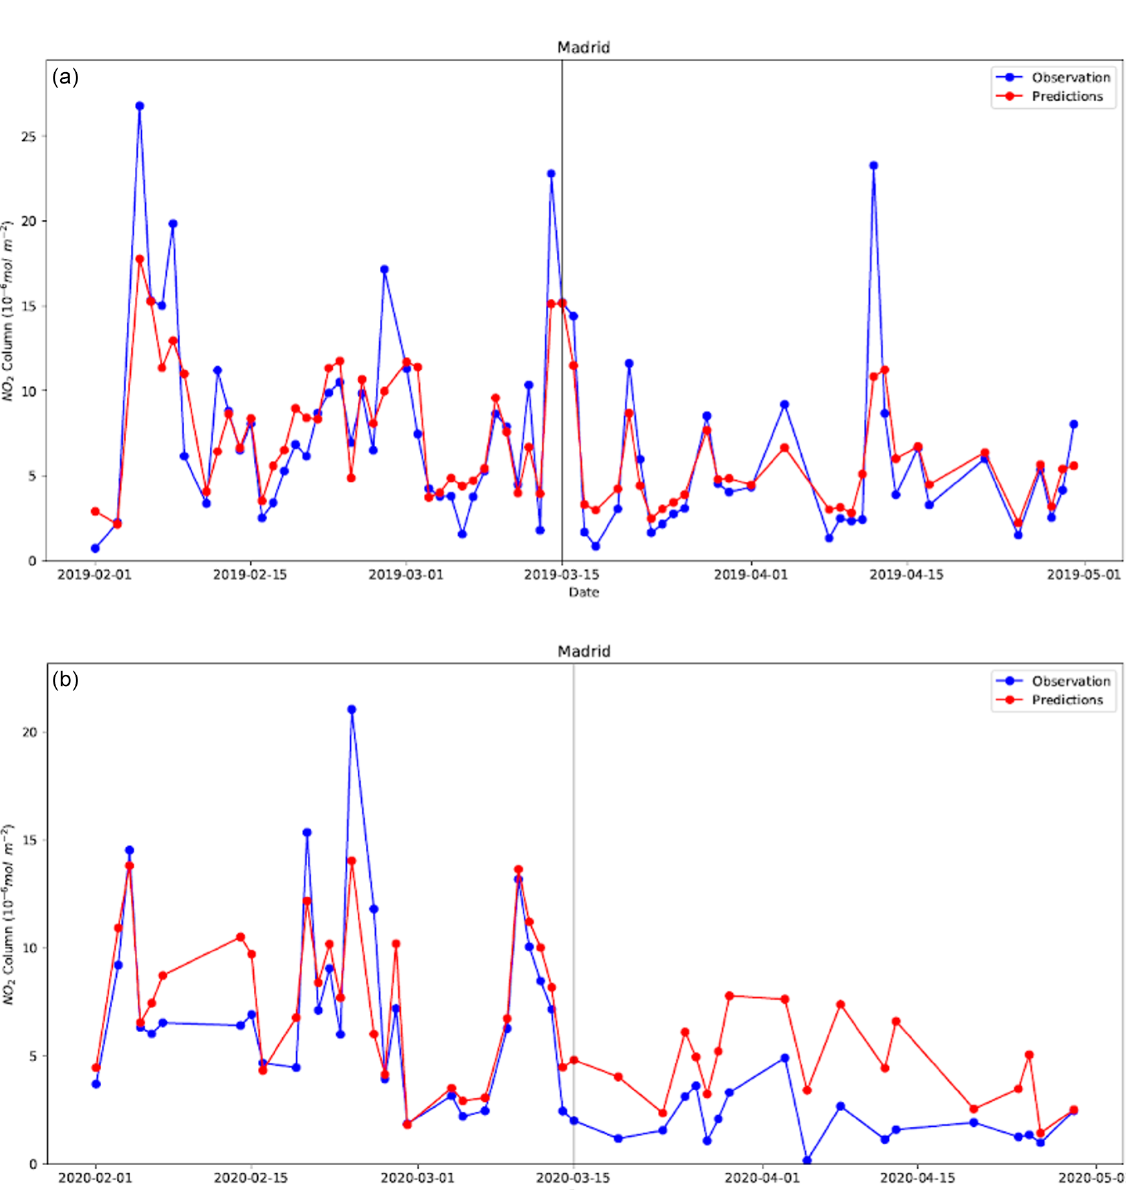
Figure 5. Example of a time series over Madrid illustrating the performance of the machine learning NO 2 column predictions for February– March–April 2019 (a) and the same period in 2020 (b)